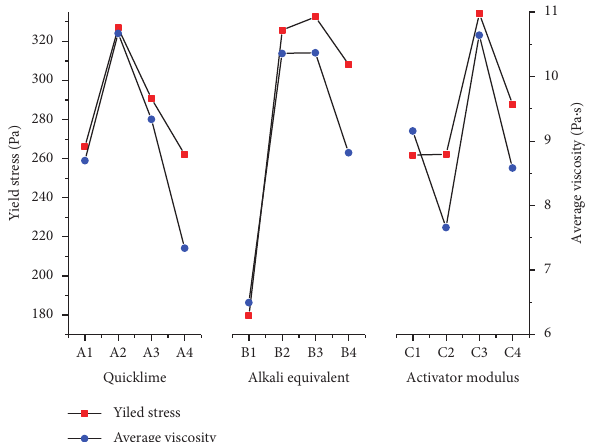
Figure 7: Trend chart of average yield stress and viscosity VS factor